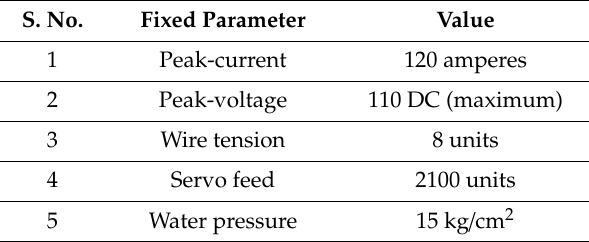
Table 3. Fixed parameters and values.